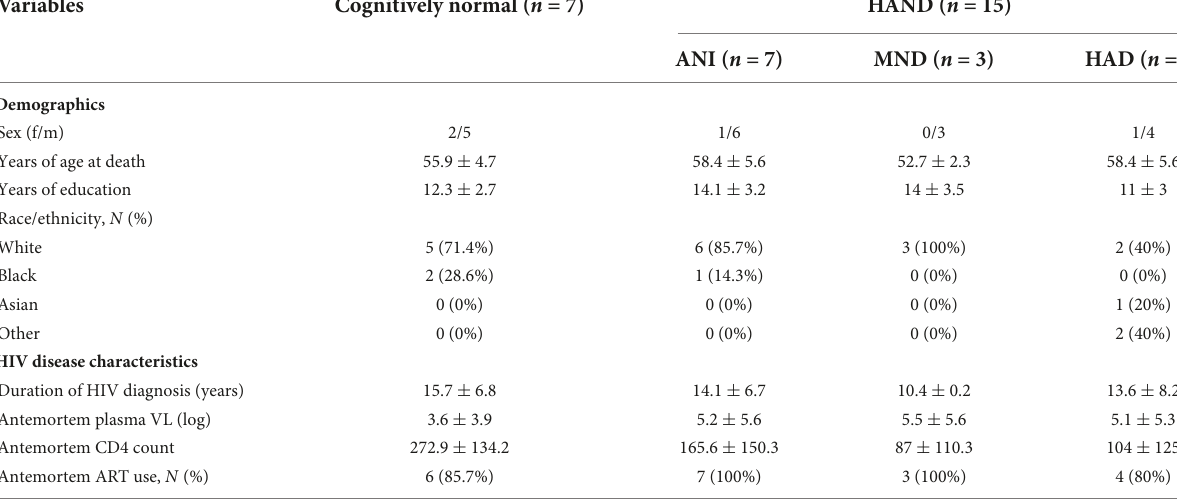
TABLE 1 Clinical characteristics of HIV + brain